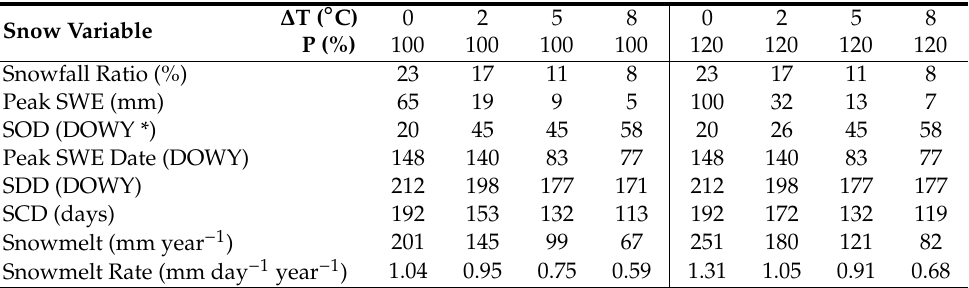
Table 2. Sensitivity of snow variables to selected climate change scenarios. The snow onset date (SOD) and the snow disappearance date (SDD) are the first and last days of the water year with snow on the ground (SWE > 0.1 mm), respectively. SCD, snow cover